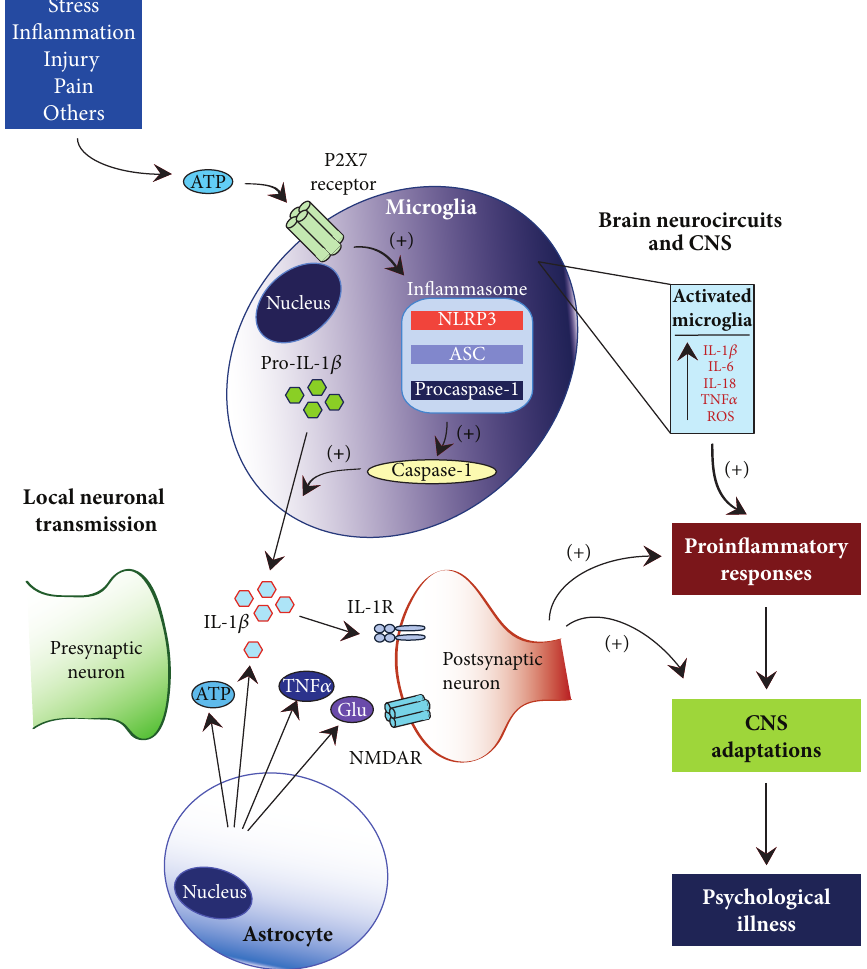
Figure 2: Role of microglia and inflammasome complex in development of inflammatory responses. Systemic disorders and pathological statescaninduceactivationofmicroglialcellsleadingtoalocalreleaseofproinflammatorycytokines(PICs).Thisprocessincludesstimulation of microglial P2X7 receptors and downstream activation of the NLRP3 inflammasome. Consequent systemic increases in circulating PICs may signify one of the fundamental mechanisms responsible for initiation of molecular and functional alteration within the CNS that underlie developmentofmentalillness.Interleukin(IL),tumornecrosisfactoralpha(TNF 𝛼 ),reactiveoxygenspecies(ROS),NOD-likereceptorfamily, pyrin domain containing 3 (NLRP3), apoptosis-associated speck-like protein containing a CARD (ASC), N -methyl-D-aspartate receptor (NMDAR), and purinergic type 2X7